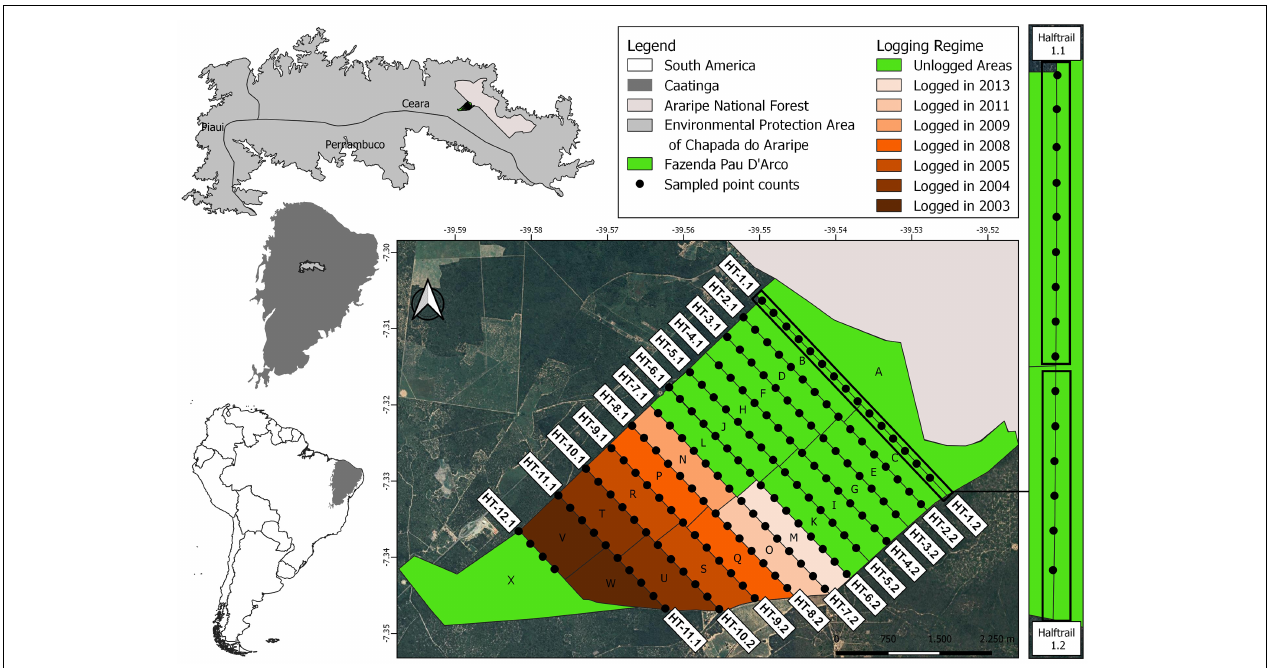
FIGURE 1 | Location of the study area and arrangement of the 160 count points in the forest management area of Fazenda Pau D’Arco, Crato, Ceará, Brazil in 2014. Polygons represent forest stands, green areas indicate unmanaged areas and brown scale indicates different logging times (in years). Trails that divide the forest stands were split into 23 half-trails (with a forest stand on each side) and used as a sample unit. TABLE 1 | Forest management scheme until 2014 at the Fazenda Pau D’Arco, Crato, Ceará, Brazil. Logged areas Unlogged